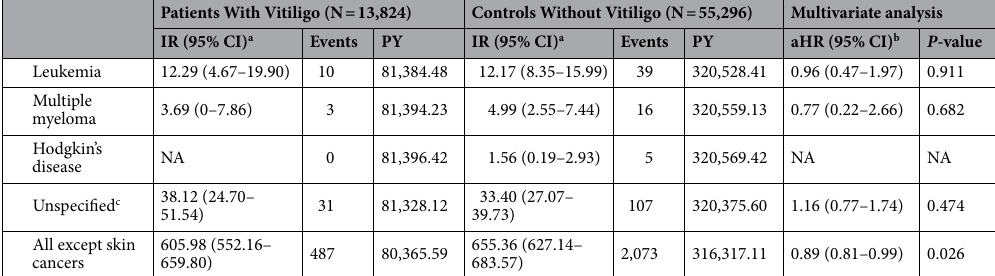
Table 2. Incidence rates and adjusted hazard ratios of cancer risk between vitiligo patients and reference subjects. BCC basal cell carcinoma, CI confidence intervals, HR hazard ratio, IR incidence rates, MM malignant melanoma, PY person-years, SCC squamous cell carcinoma. a Incidence rate per 100,000 person-years. b Adjustment for age, gender, hospital visits, and comorbidities listed in Table 1. c Digestive system includes gastrointestinal system, liver, spleen, gall bladder. Respiratory system includes respiratory and intrathroax organs. Skin and others include skin, bone, connective tissue, and breast. GU system includes genital organs: prostate, scrotum, and urinary tract, as well as uterus, cervix, and ovaries. Hematopoietic system includes leukemia, lymphoma, and other hematologic cancers. Unspecified include other malignant solid tumors not mentioned above.